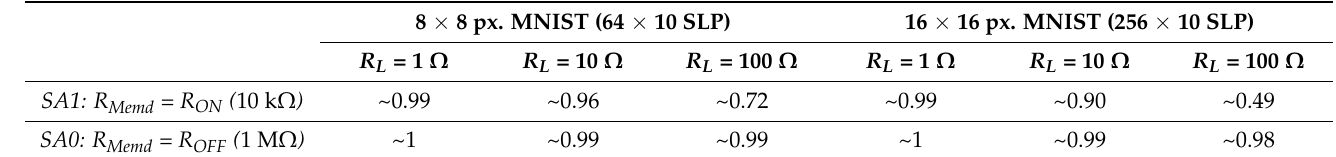
Figure 4. Inference accuracy vs. FD ratio for different values or R L is presented for the ( a ) SA1, ( b ) SA0, and ( c ) SA0_nE cases. ( d ) CPA Inference accuracy vs. ratio of biased stuck-at-ON devices. Each marker corresponds to an MC run. Data are codified in terms of the nominal fault ratio (marker type) and CPA size (marker colour), e.g., blue circle markers indicate the inference accuracy results for simulations of the 8 × 8 px. image CPAs with 1% of faulty devices, whereas red pentagon markers stand for the results obtained from 16 × 16 px. image CPAs and 30% of faulty devices. The case of 30% of faulty devices (pentagonal markers) have been highlighted for the three CPA sizes considered to provide a guide to the eye: As the CPA size increases, the ratio of biased faulty devices decreases from ~5% in the 1280 sys. CPA, to ~3.7% in the 5120 sys. and finally to ~2.3% in the 15,680 sys CPA. Table 1. V cell /V read ratio, calculated with the equivalent series-like simplified